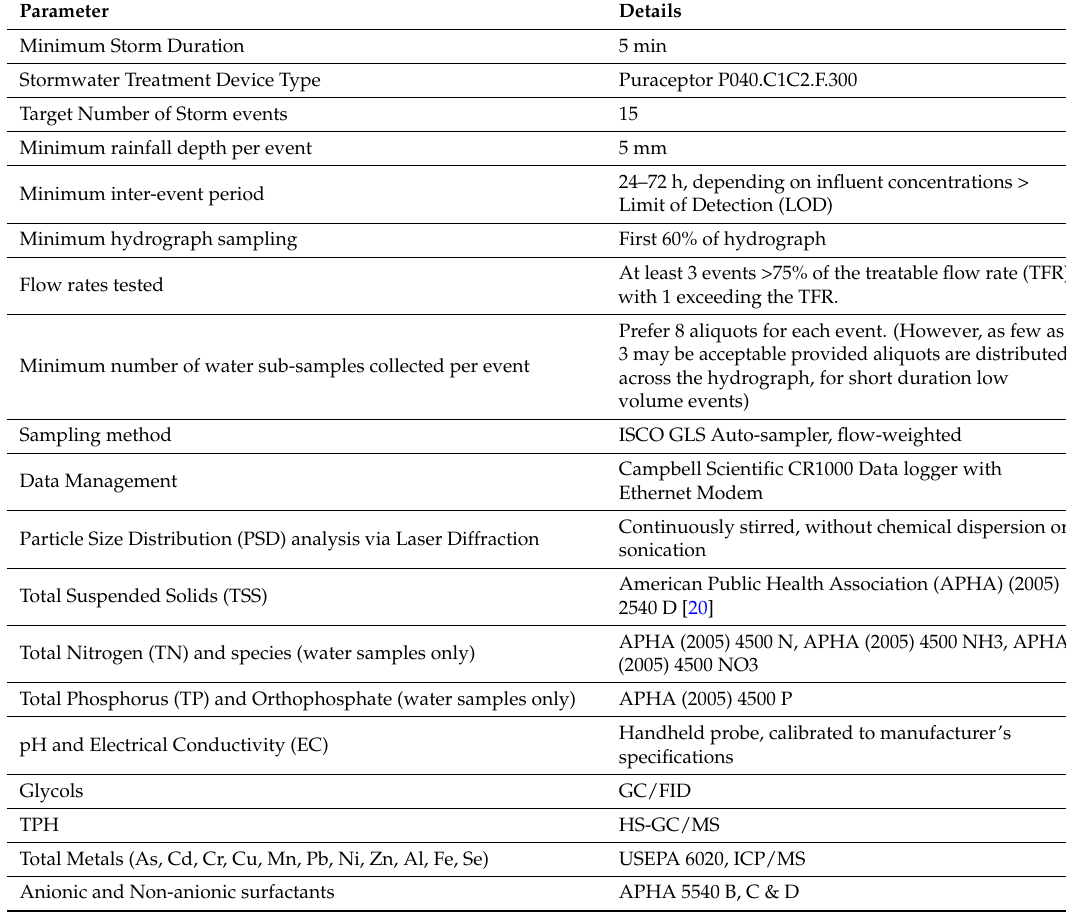
Table 4. Southport Field Testing Protocol